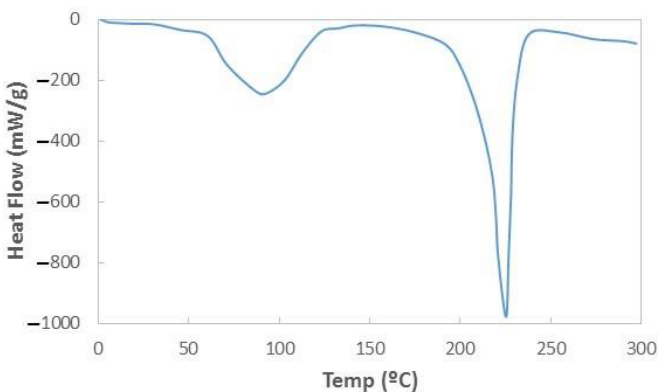
Figure 8. Differential scanning calorimetry (DSC) thermogram of a reference PA6 NFs layer used in our sensing tests.